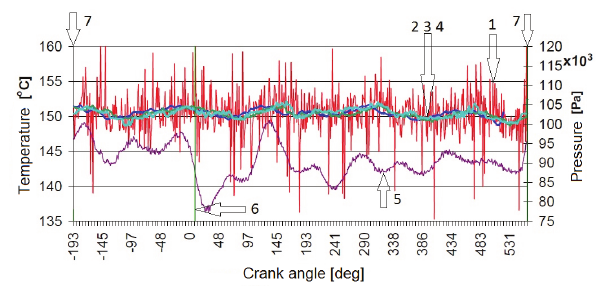
Fig. 4. Temperature change curves recorded in the exhaust channel of the Farymann D10 diesel engine with a type K thermocouple (exposed junc- tion, ceramic sheath) during one of the work cycles filtered in Matlab: 1 – temperature recorded with a thermocouple with exposed junction, 2 – temperature curve after the Savitzki and Golay filter, 3 – temperature curve after the median filter, 4 – temperature curve after the envelope filter 5 – pressure in the exhaust channel, 6 – exhaust valve closing signal, 7 – exhaust valve opening signal